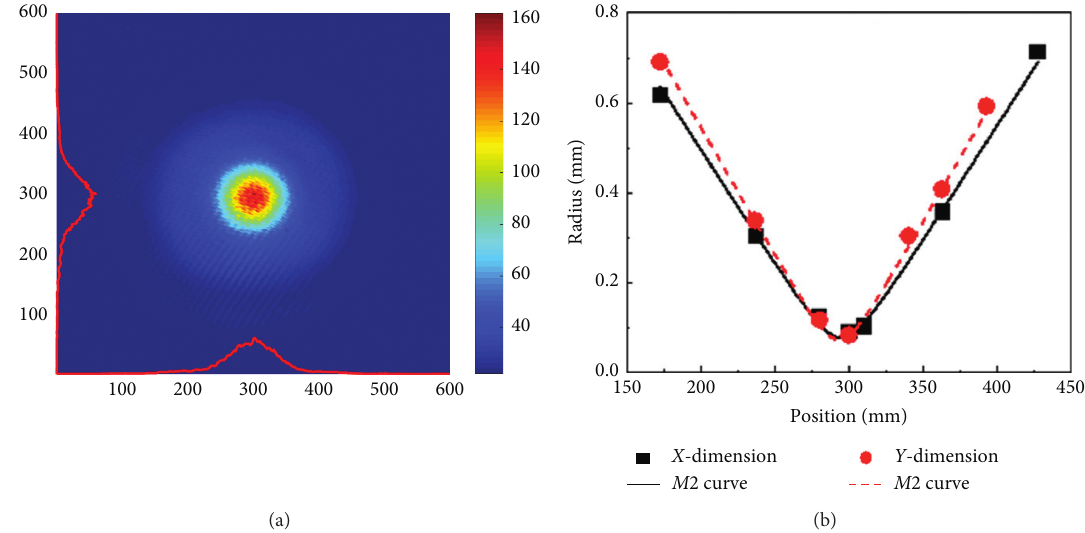
Figure 6: (a) The beam intensity profile of the SHG laser output measured by CCD and (b) the beam quality factors of M 2 laser Figure 5. Each point was calculated from 100 shots with other conditions same such as amplifiers voltage constant, and the energy of the fundamental frequency and the fre- quency doubling laser pulses were recorded simultaneously by inserting the wedge plates into the laser path and op- erating two energy meters. From the illustration, with the increase of the repetition rates, the pulses energy and the frequency conversion efficiency drop slightly. It is because of the waste heat accumulating during the operation in both laser crystal and the KTP. Overall speaking, the laser system maintains a stable operation under different rates, and the energy of 1064 nm and 532 nm reaches 860 mJ and 550 mJ separately. The RSD (relative standard deviation) of laser pulse energy is less than 6.2%.